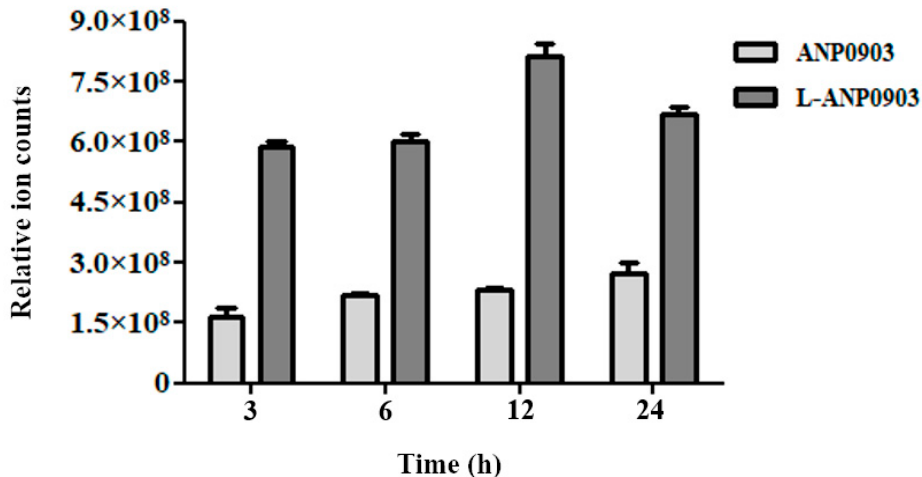
Figure 6. ANP0903 and liposomal ANP0903 intracellular intake. HepG2 cells were treated with 100 µM ANP0903, as free molecule in solution or formulated in PEG-liposomes, at indicated times and the amount of ANP0903 accumulated in HepG2 cells was reported as an area of the chromatographic peak. Results were reported as means of three independent replicates ± Standard Deviation (SD).